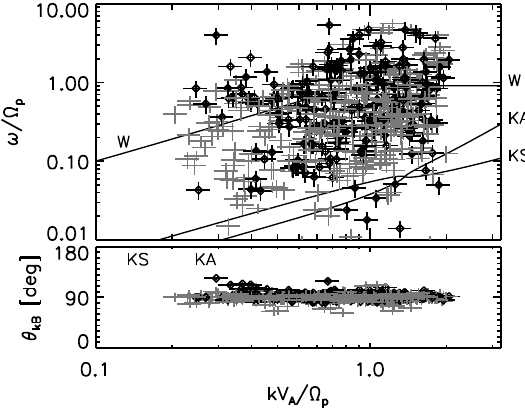
Figure 2. Top panel: scatter plot of wave frequencies in the plasma rest frame as a function of the wavevector magnitude for the dis- crete waves (identified as the local peaks in the energy spectra) ob- served by the Cluster spacecraft (Perschke et al., 2014). Data points in gray diamond indicate low-beta conditions ( β i < 1) that in black cross high-beta conditions ( β i ≥ 1) in the solar wind. Theoretical dispersion relations for whistler mode (W), kinetic slow mode (KS), and kinetic Alfvén mode (KA) for β i = 1 and θ kB = 88 ◦ are over- plotted. Bottom panel: wavevector angles from the mean magnetic field.